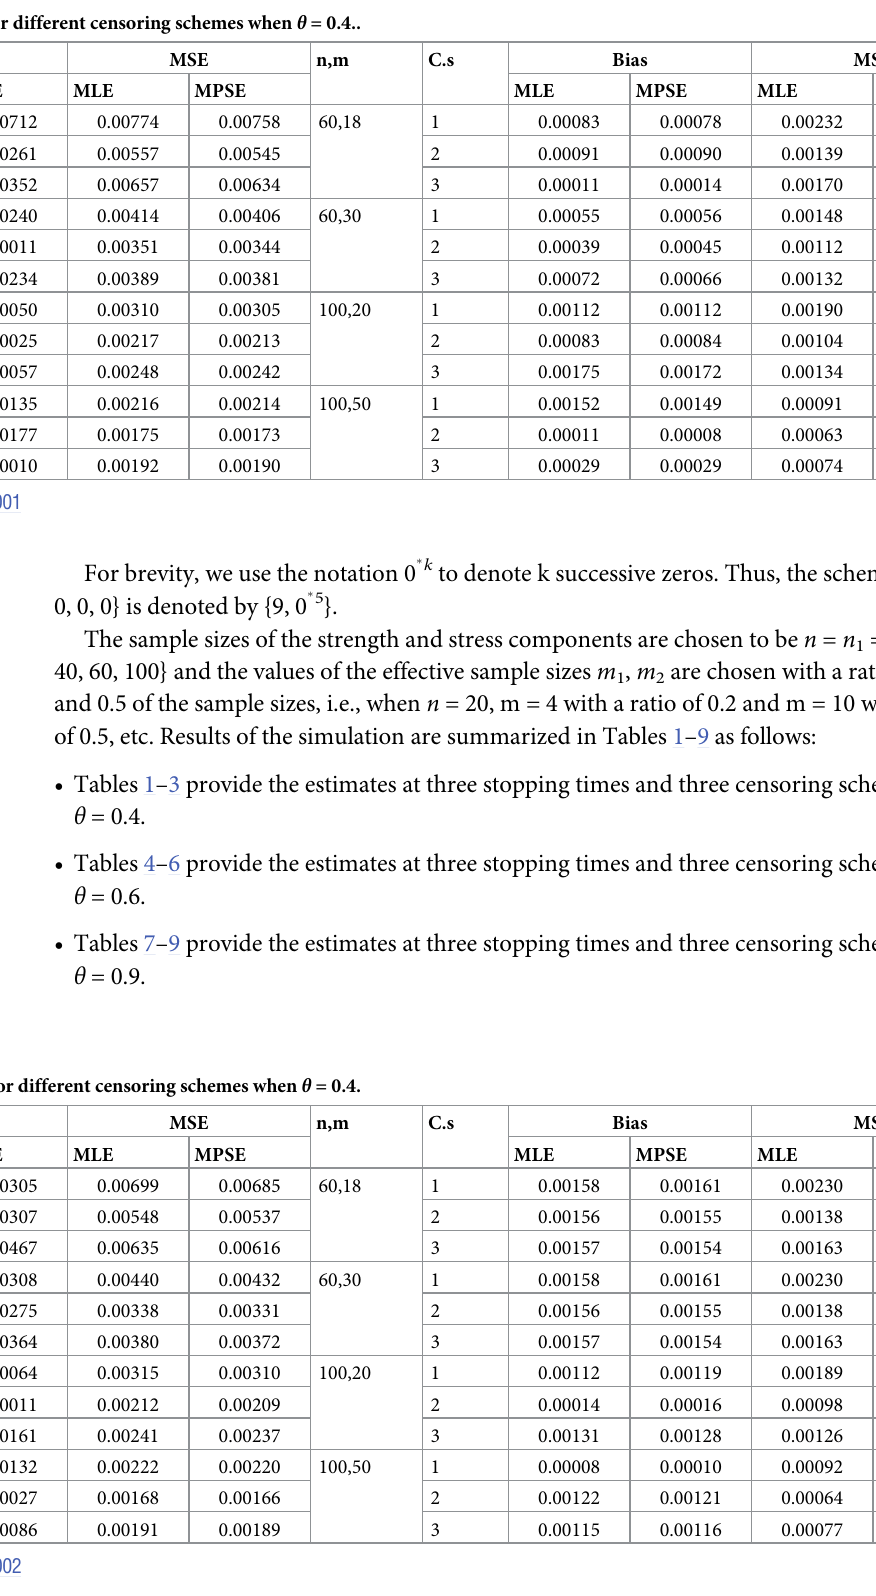
Table 1. Bias and MSE of θ with T